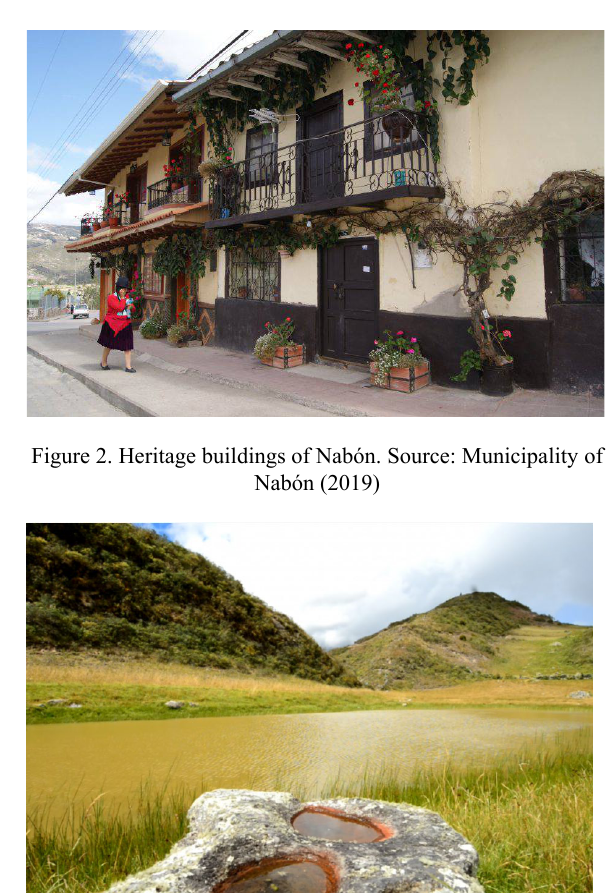
Figure 3: Part of an archaeological site in Nabón. Source: Municipality of Nabón